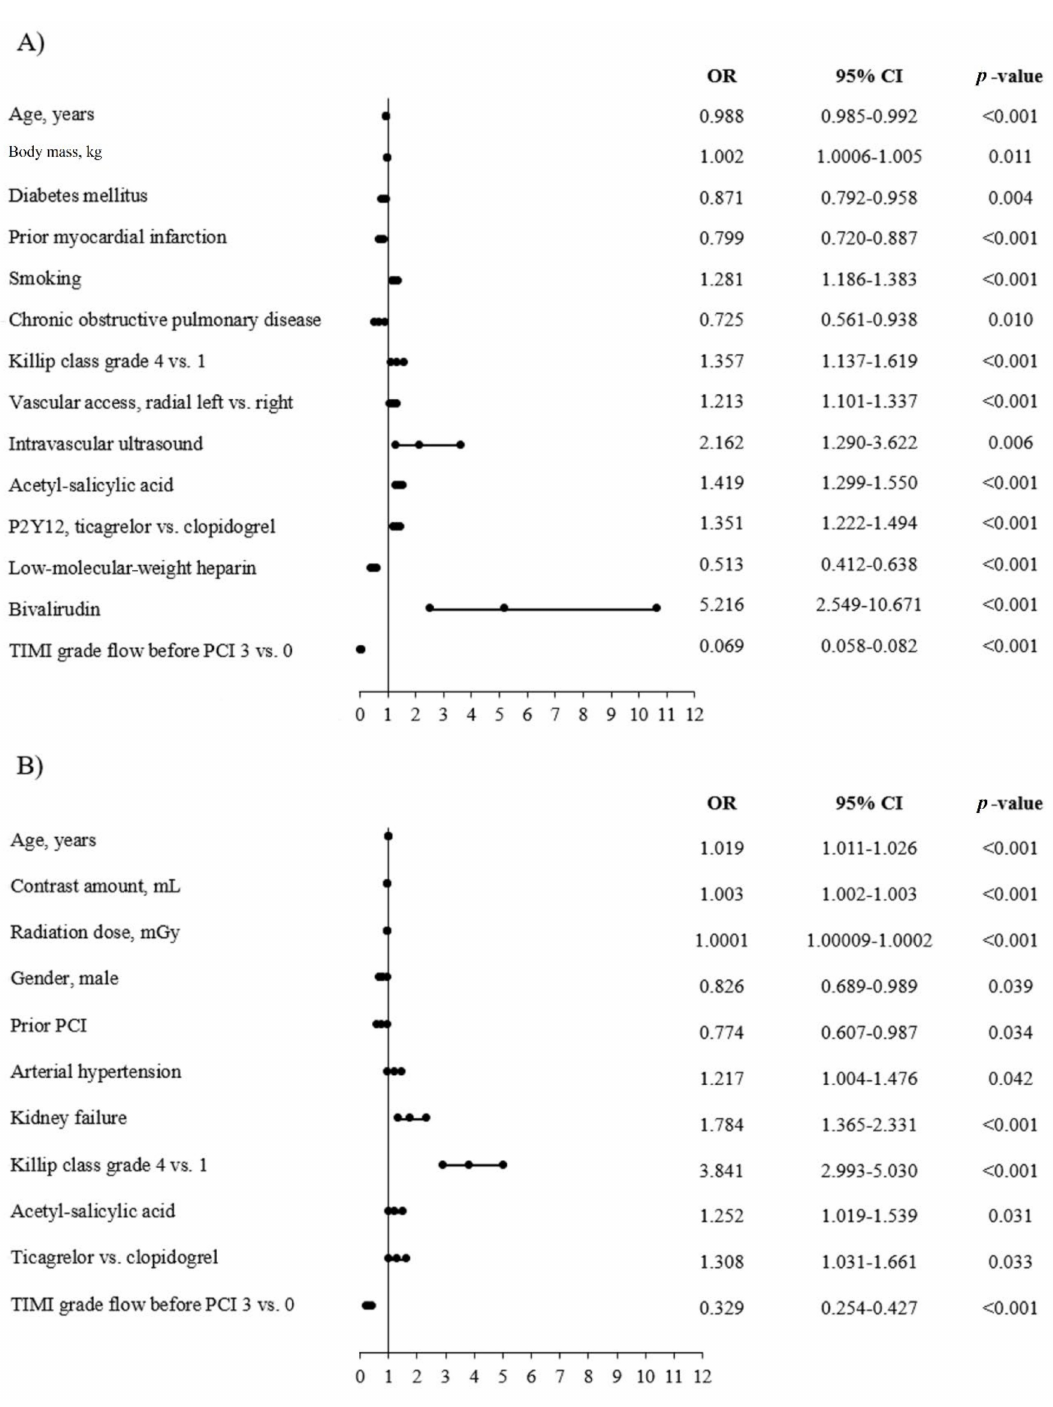
Figure 2. Predictors of TA and no-reflow phenomenon in the overall group of patients with AMI. ( A ) Thrombus aspiration. ( B )